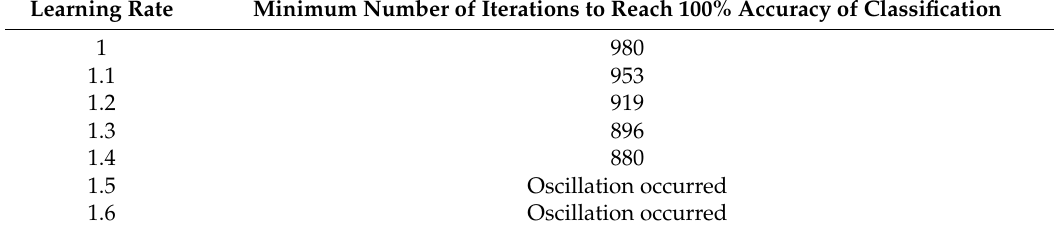
Table 6. Adjust the learning rate.